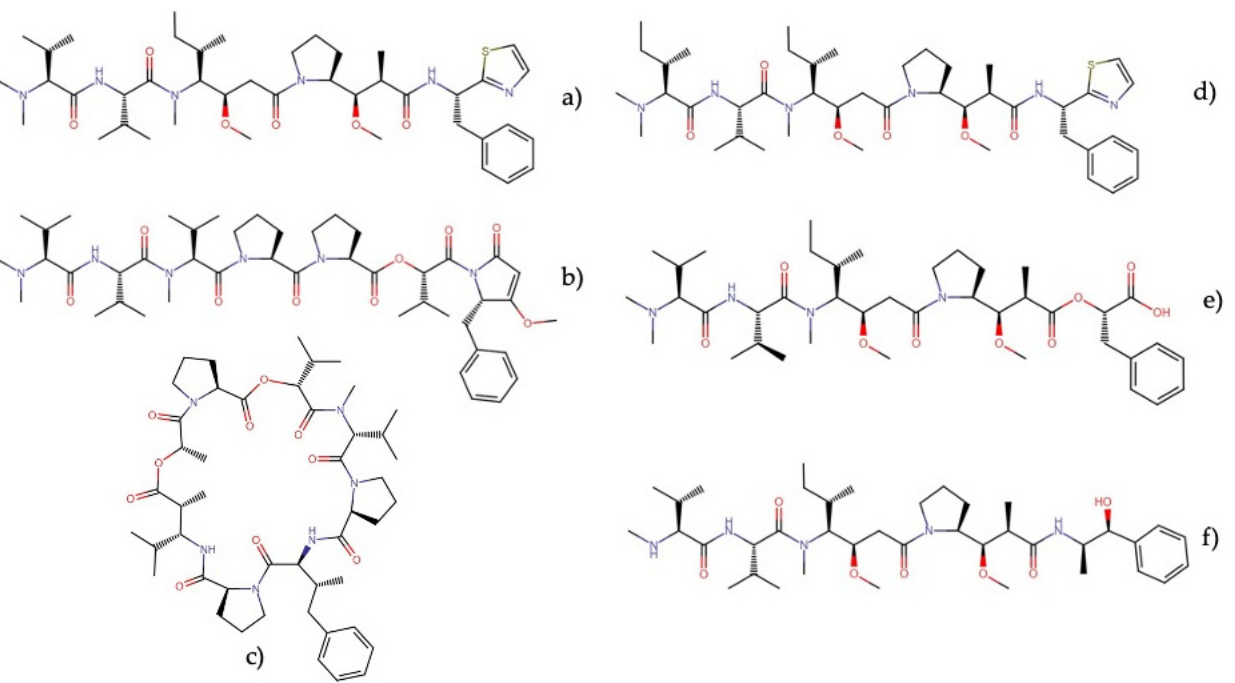
Figure 12. Chemical structures of representative dolastatins and their derivatives: ( a ) dolastatin 10, ( b ) dolastatin 15, ( c ) dolastatin 16, ( d ) symplostatin 1, ( e ) symplostatin 3, and ( f ) MMAE. Members of this family (dolastatins 10 and 15) are potent microtubule depolymerizers that induce cell cycle arrest in the G2/M phase and trigger apoptosis in several tumor cell